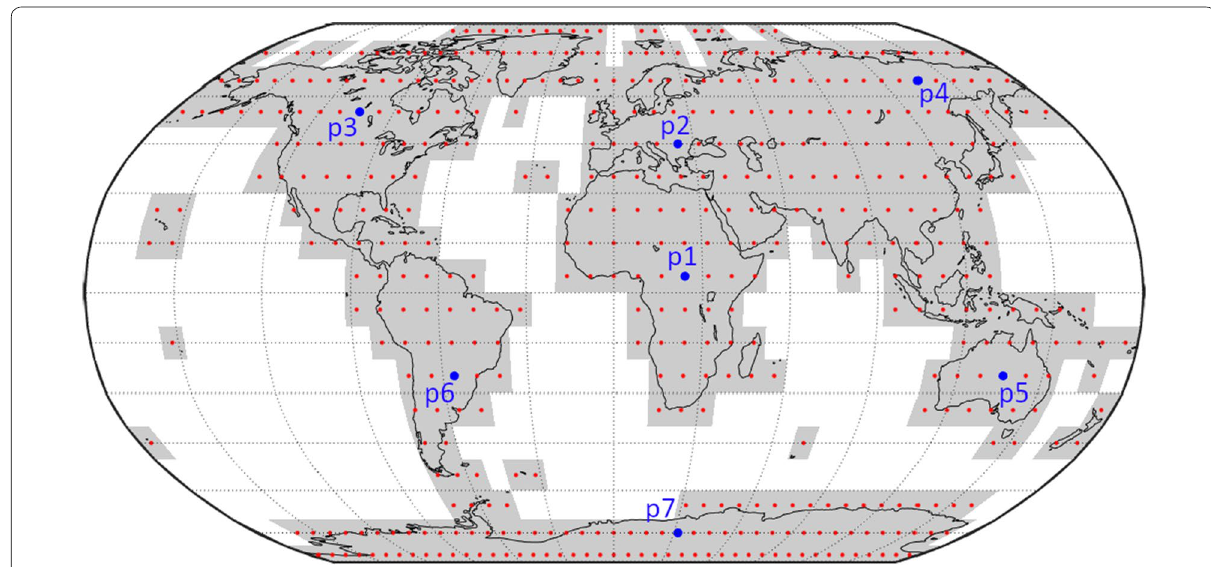
Fig. 2 Investigated antenna positions (small red dots) and their corresponding grid cells (grey areas). The big blue dots highlight the seven training locations used to define the weights used in scheduling, see “Scheduling”